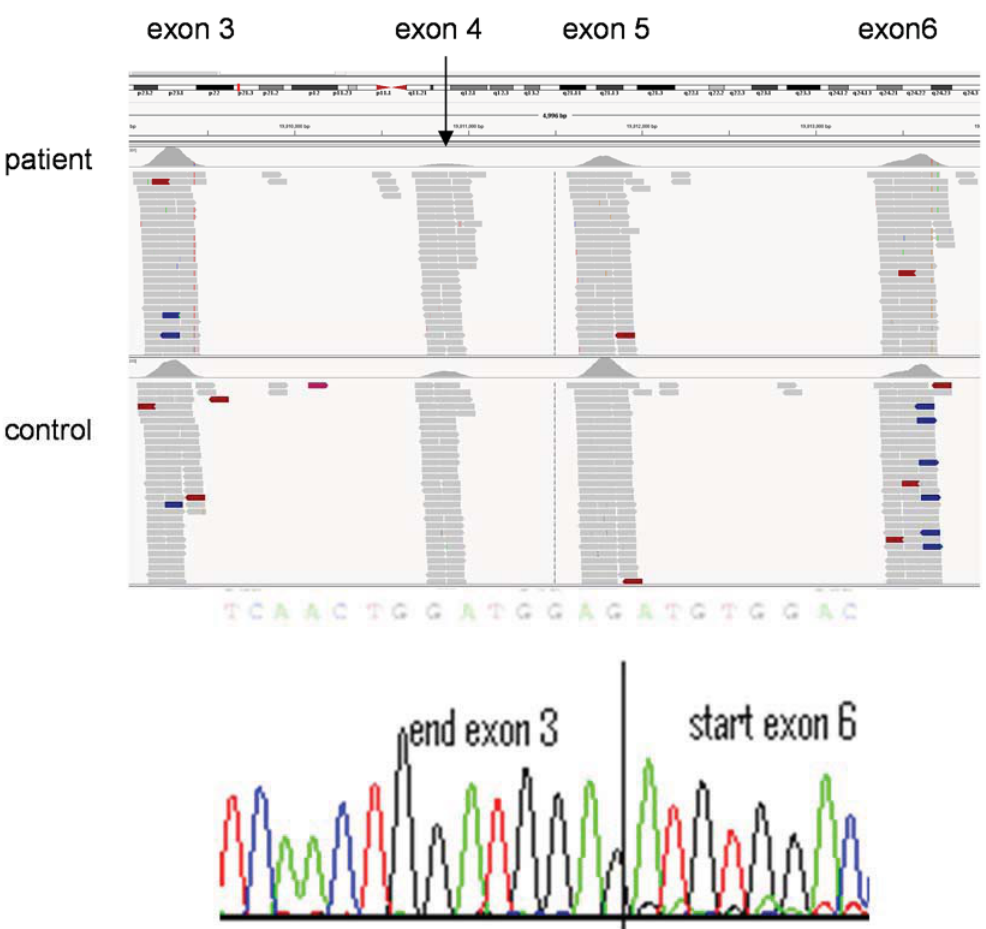
Figure 4. Copy number variation detected by exome sequencing. Decreased numbers of sequence reads are present in exons 4 (e.g., see arrow) and 5 of LPL in the individual with lipoprotein lipase deficiency (top panel) compare to exons 3 and 6 (similar number of reads in patient DNA sequence and that of a control individual below). This indicates a heterozygous deletion of exons 4 and 5 of LPL , which is confirmed in the bottom panel by sequencing of cDNA generated from RNA extracted from lymphocytes from the affected